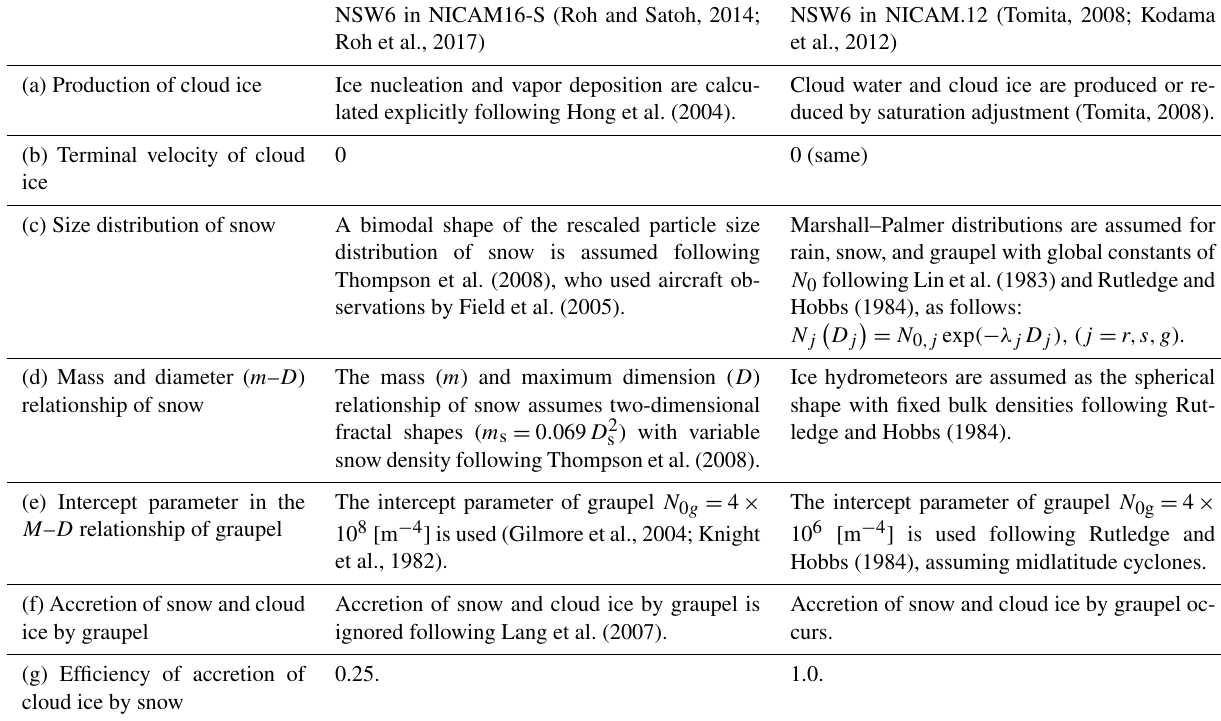
Table 5. Summary of the key changes in the NSW6 scheme by Roh and Satoh (2014) and Roh et al. (2017). ∗